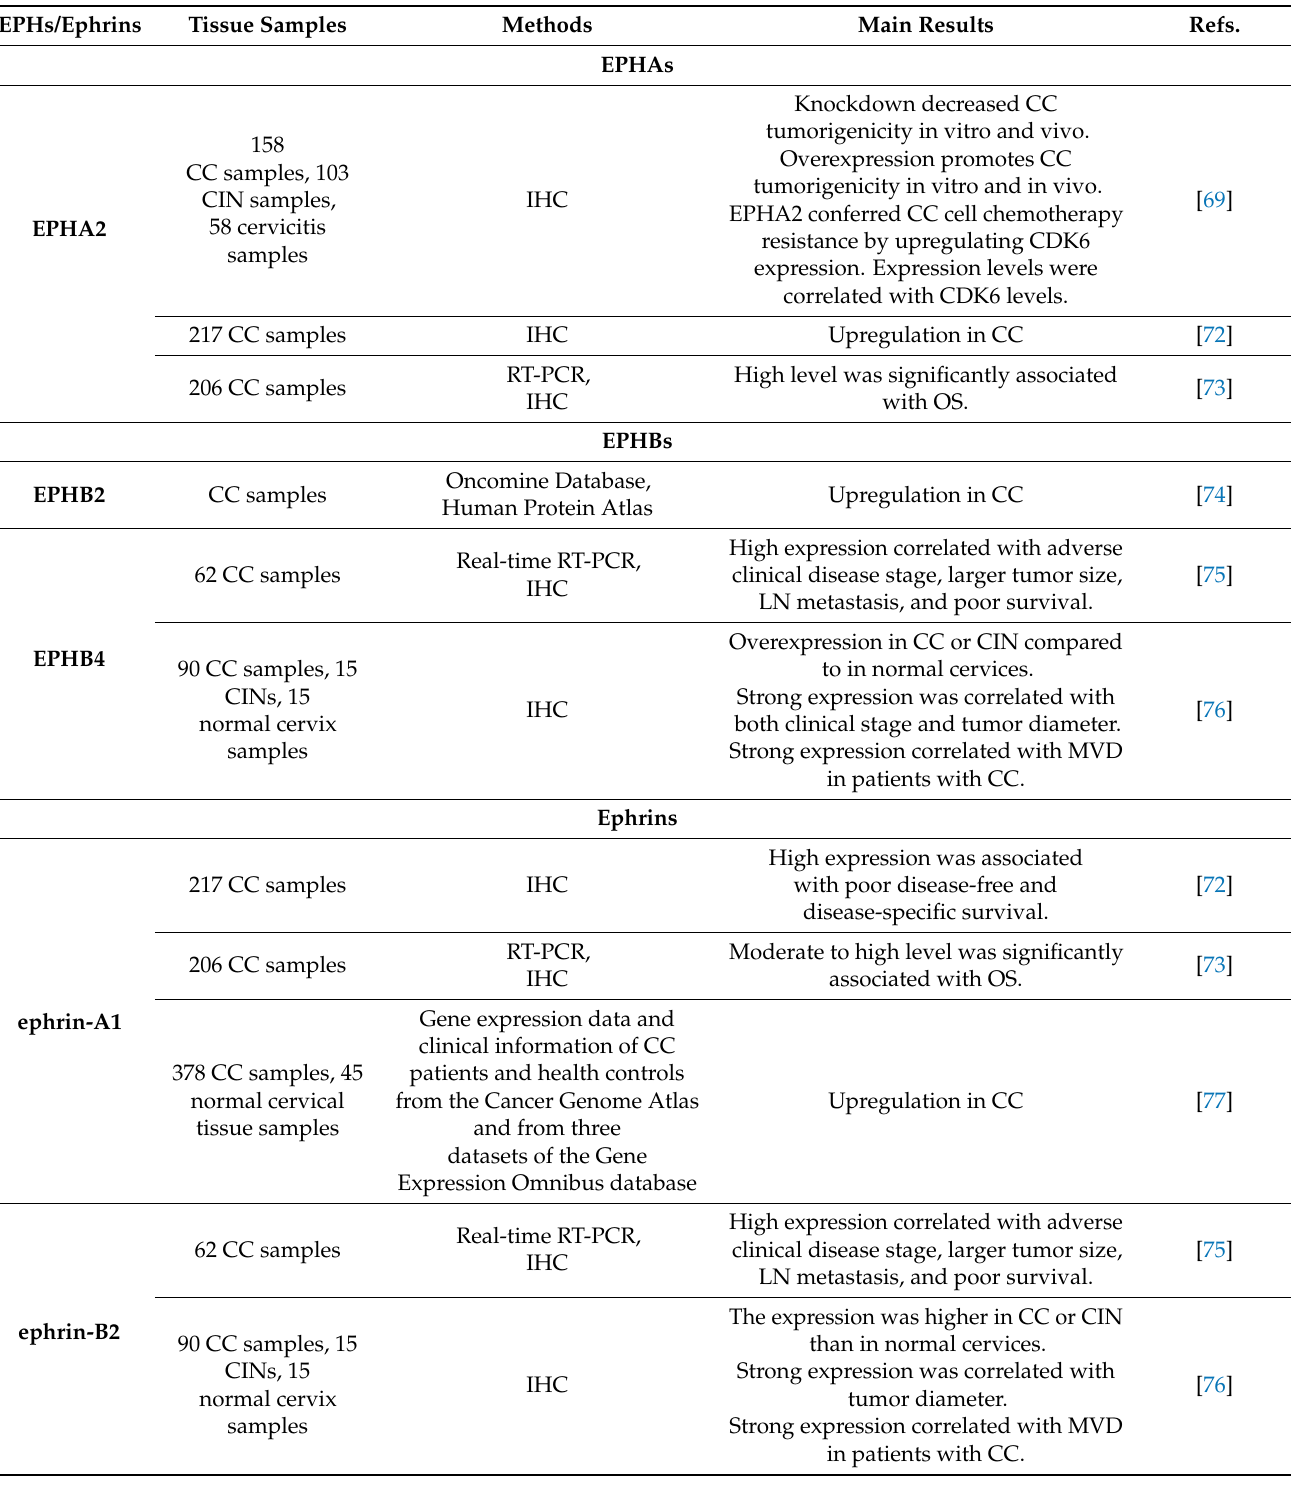
Table 7. The role of the EPH/ephrin system in CC tissue